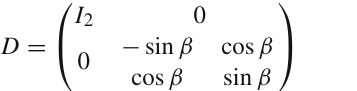
The effect of changing | μ | can be seen by comparing the upper rows from Fig. 5 with the lower rows. The value of μ changes from μ = 2 M s ( μ = 3 M s ) to μ = M s from the top left (right) figure to the bottom row. Comparing values for m h for ϕ A = 0 ◦ in the upper left (right) plot with the ones for | A | = 10 TeV ( | A | = 15 TeV) in the lower left plot leads to a rise of the Higgs-boson mass by roughly 1 GeV.